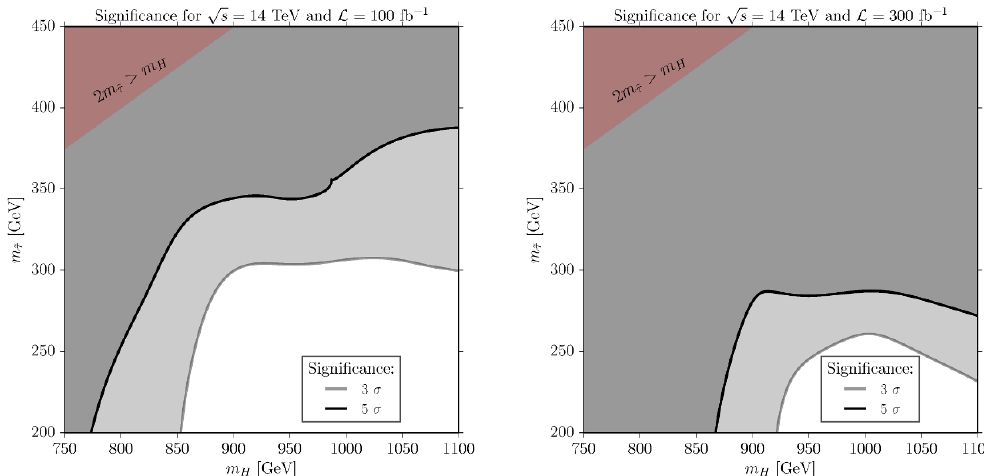
Figure 3 . Signal signi(cid:12)cance in the [ m H , m ~ (cid:28) ] plane, within the large stau-mixing MSSM scenario, p 1 for a center-of-mass energy of s = 14 TeV and total integrated luminosities of 100 fb (cid:0) 1 (left panel) and 300 fb (cid:0) 1 (right panel). The light gray area corresponds to signi(cid:12)cances at the evidence level (3 standard deviations) and the dark gray area to signi(cid:12)cances at the discovery level (5 standard deviations). Finally, the white area represents signal signi(cid:12)cances below 3 (cid:27) and the shaded red area is forbidden because the decay mode H ! ~ (cid:28) 1 ~ (cid:28) (cid:3) is kinematically 1